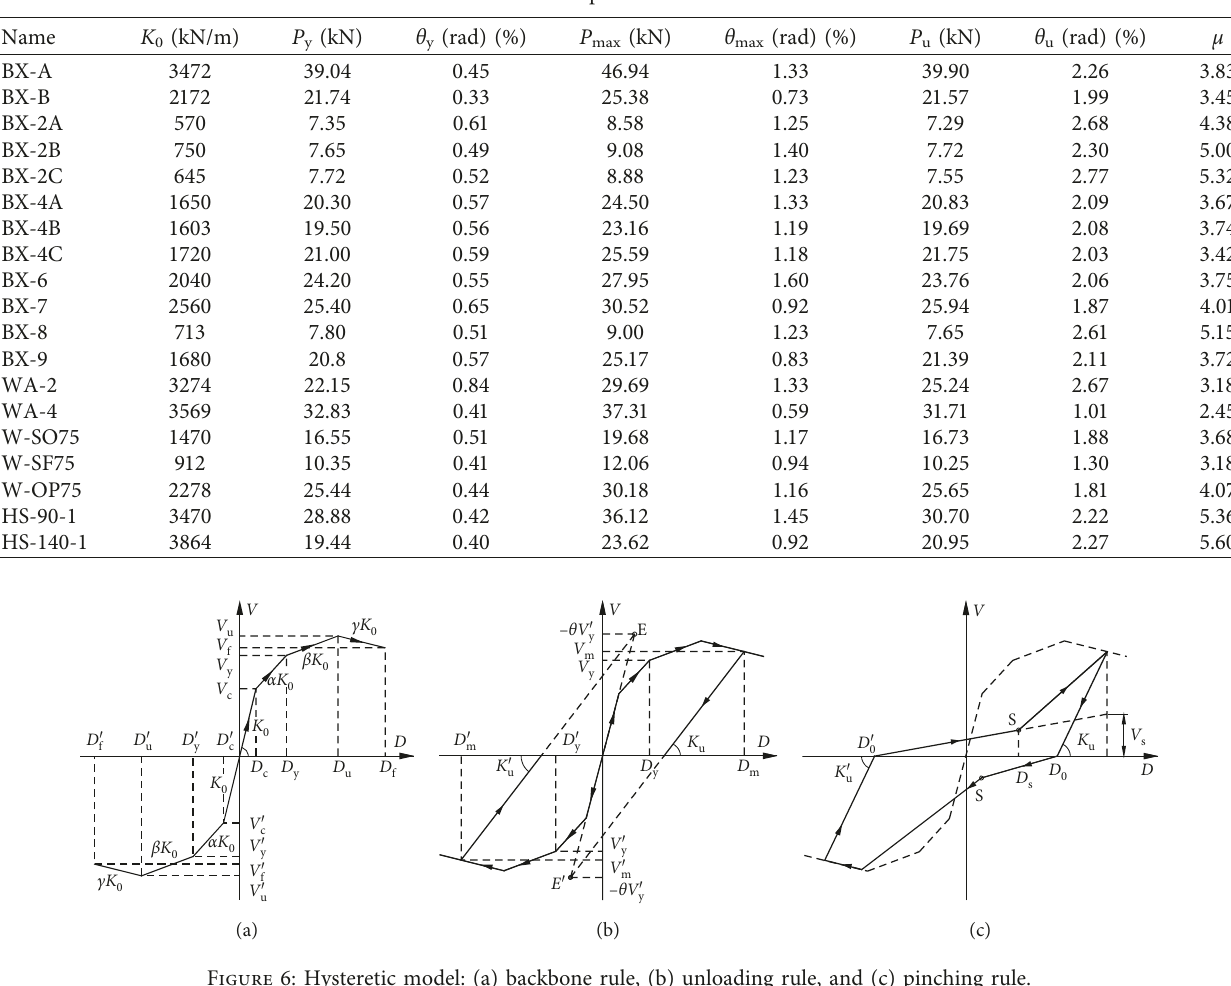
Table 2: Experimental results.